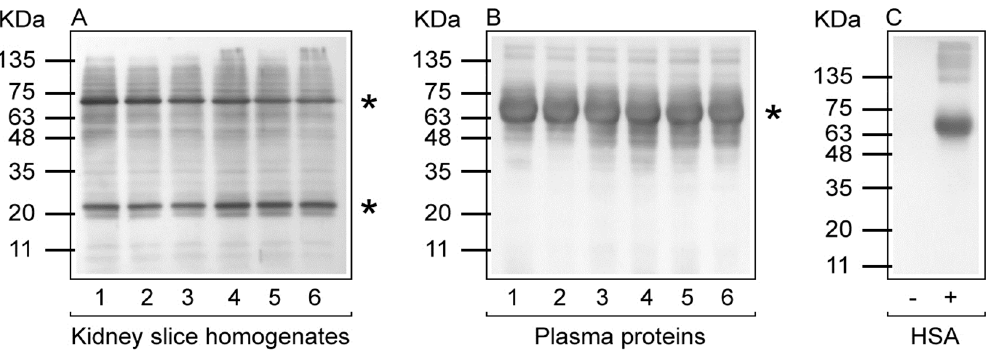
Figure 4. Protein carbonylation in rat kidney slice homogenates and plasma proteins. Representative Western blot with anti-DNP antibody for PCOs of kidney slice homogenates ( A ) and plasma proteins ( B ) of adult male Sprague–Dawley rats treated with a single i.t. instillation of AgNPs or AgNO 3 . In both ( A ) and ( B ): 1, control (7 days); 2, AgNO 3 (7 days); 3, AgNPs (7 days); 4, control 28 days); 5, AgNO 3 (28 days); 6, AgNPs (28 days). ( C ) human serum albumin (HSA) in the reduced form ( − ) and in the carbonylated/oxidized form (+). Protein molecular weight markers are shown on the left side of each panel. Although there were no differences between controls and treated samples, the most carbonylated proteins are highlighted by an asterisk (*) in kidney and plasma samples.